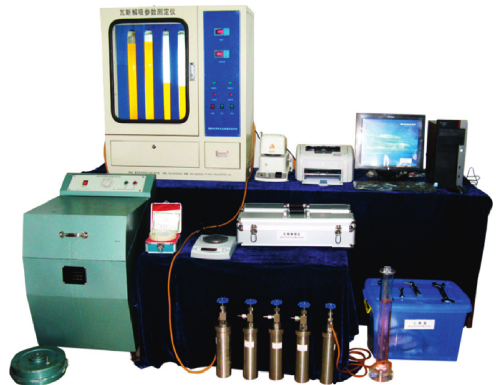
Figure 9: Direct measuring device for gas content.